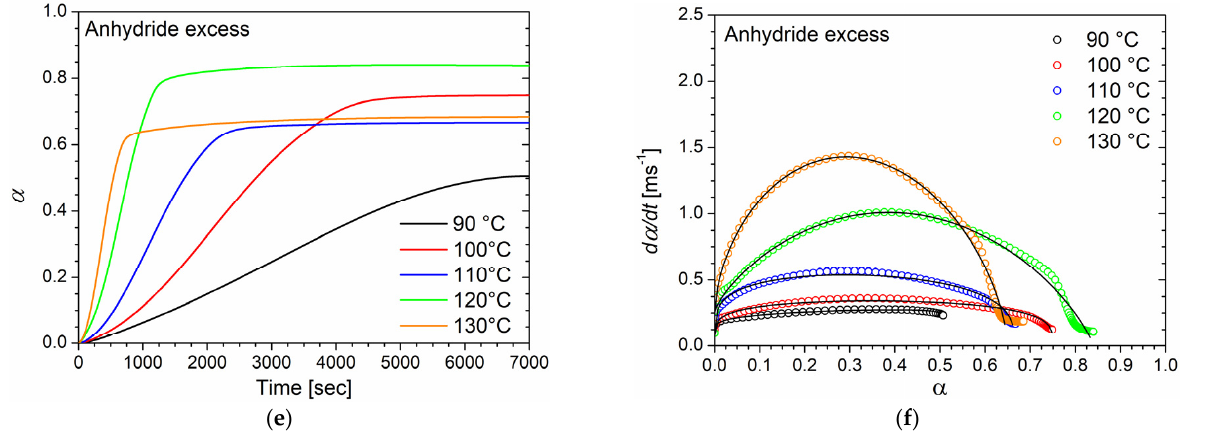
Figure 3. Plots of the degree of conversion ( α ) as a function of time and conversion rate (d α /dt) as function of conversion for epoxy/anhydride mixtures with ( a,b ) a stoichiometric ratio, ( c,d ) epoxy excess, and ( e,f ) anhydride excess, respectively. Solid lines in ( b ), ( d ), and ( f ) represent the fitting curves of the experimental data by the Kamal model (Equation (9)).